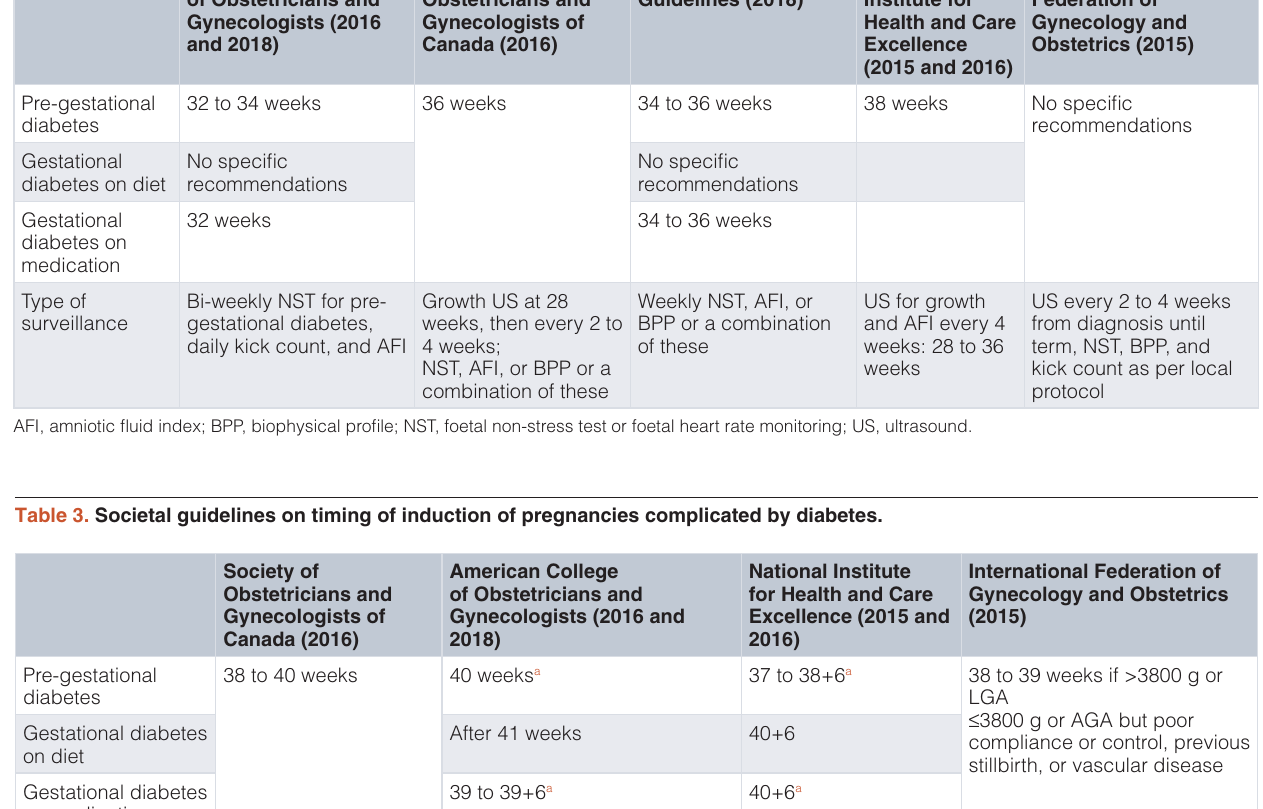
Table 2. Societal guidelines on timing and type of foetal antenatal surveillance in pregnancies complicated by diabetes. American College of Obstetricians